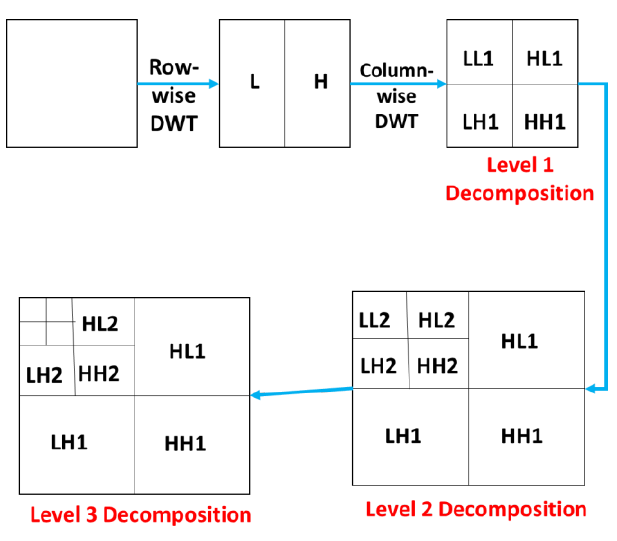
Figure 2. 2D-DWT: Three level